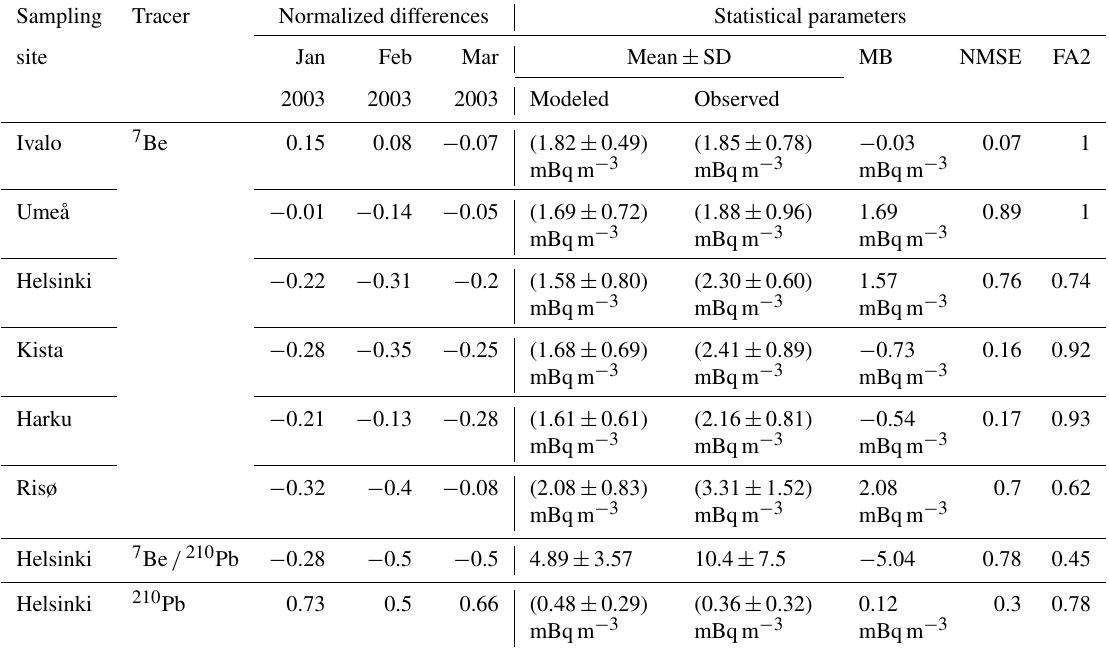
Table 2. Normalized differences between the simulated and observed 7 Be monthly means, calculated as differences between the simulated and the observed values, normalized over the observed value, at each sampling site (left). Statistical parameters (mean ± SD = mean ± standard deviation; MB = mean bias; NMSE = normalized mean square error; FA2 = factor of 2) indicating the model performance in reproducing observed 7 Be monthly means at the six sampling sites in northern Europe and 7 Be / 210 Pb and 210 Pb monthly means in Helsinki